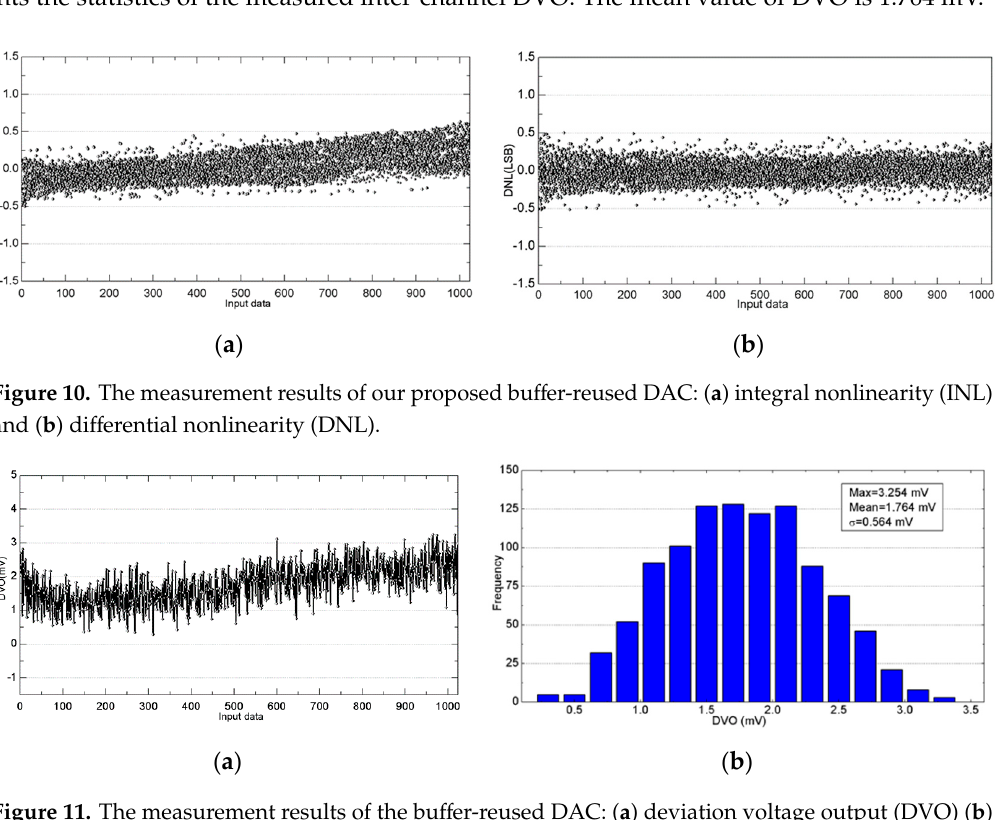
Figure 11. The measurement results of the buffer-reused DAC: ( a ) deviation voltage output (DVO) ( b ) the statistics of DVOs.